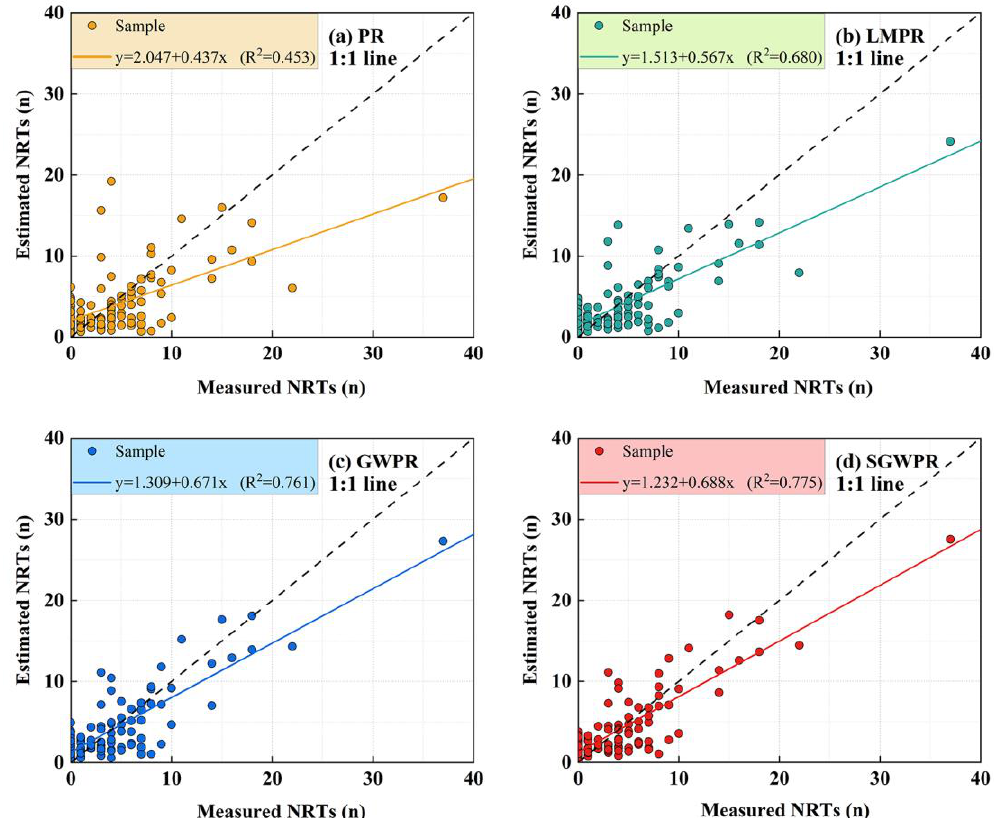
Figure 2. Scatter diagrams of the estimated NRTs (n) and the measured NRTs (n) by the four models. ( a ) PR represents the Poisson regression, ( b ) LMPR represents the Liner mixed PR, ( c ) GWPR represents the Geographically weighted PR, and ( d ) SGWPR represents the semiparametric GWPR. Note: NRTs represents the number of recruitment trees. The dotted line in the figure is the median line, the point is the measured and estimated NRTs, and the color line is the fitting line. The closer the color line is to the median line, the better the model is.